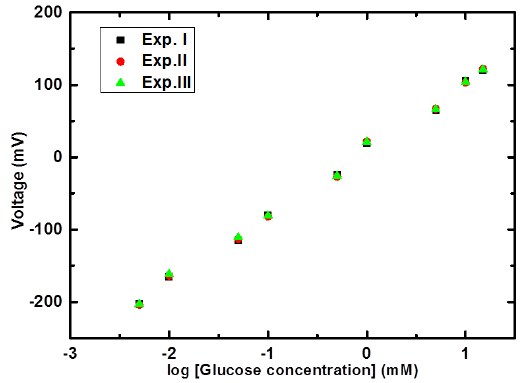
Figure 7. The repeatability curve of the proposed glucose biosensor for 3 consecutive experiments.